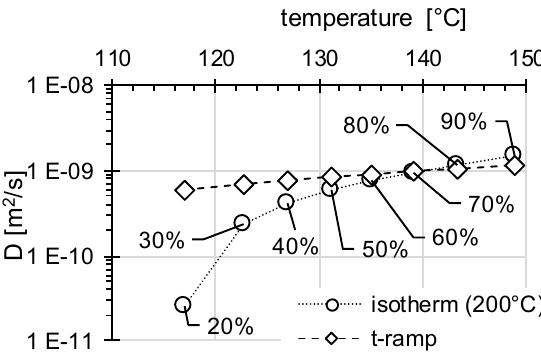
ff usion coe ffi Figure 16. Comparison of diffusion coefficients. Figure 16. Comparison of di Figure 16. Comparison of diffusion coefficients.